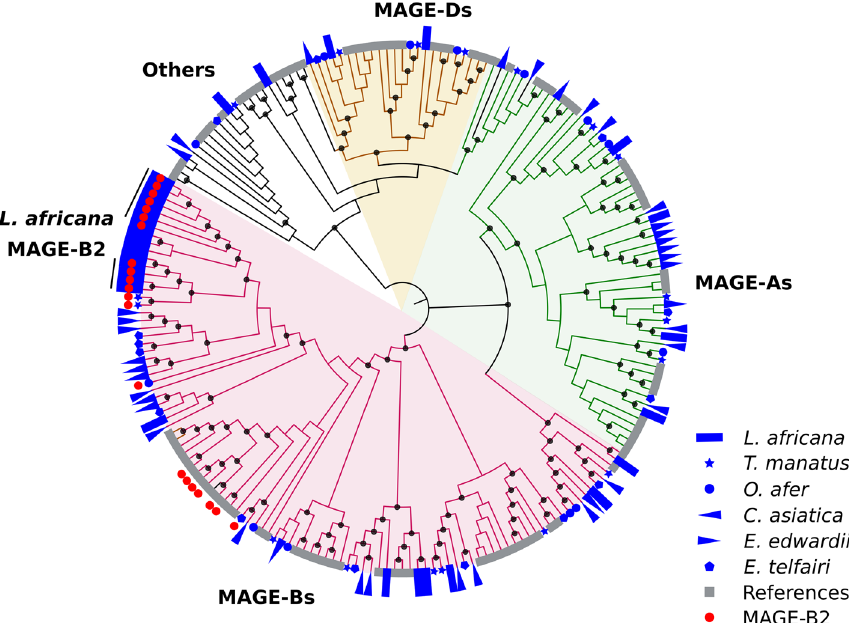
Figure 6. Unusual representation of MAGE family proteins in Afrotheria. Phylogenetic tree (generated by Neighbor-Joining method (using 332 aligned positions with 2000 bootstraps 53,54 ) depicts the number and relationships of MAGE domain family containing proteins present in Afrotheria (filled blue symbols) and reference proteomes (filled grey squares). Each Afrotherian species is depicted with a different symbol- L. africana (rectangle), T. manatus (star), O. afer (circle), C. asiatica (inward triangle), E. edwardii (outward triangle) and E. telfairi (pentagon). Tree branches are colored as green, pink, and brown with similar color background, to show the distribution of MAGE proteins corresponding to subfamilies A, B and D, respectively. Branches colored black correspond to proteins belonging to other categories of MAGE family (E, G, Nectin etc.). MAGE-B2 proteins, highlighted with filled red circles, show a higher number in L. africana than in all other species considered